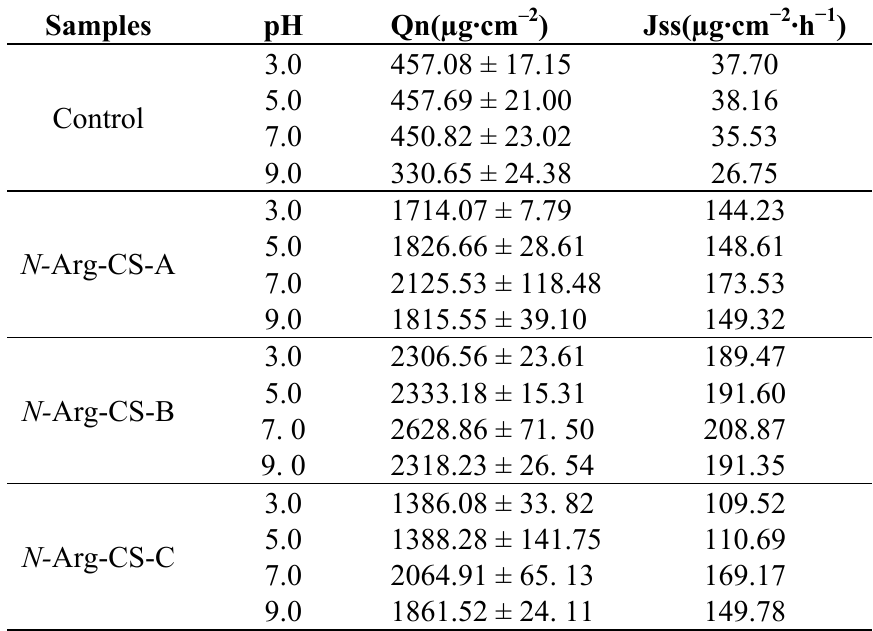
Table 2. Effect of N- Arg-CS at various pH values on the skin penetration of